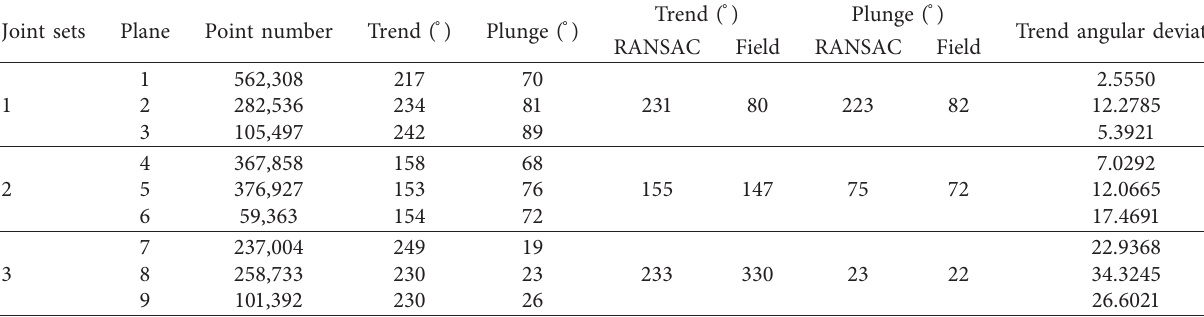
Table 3: Information of plane detection.